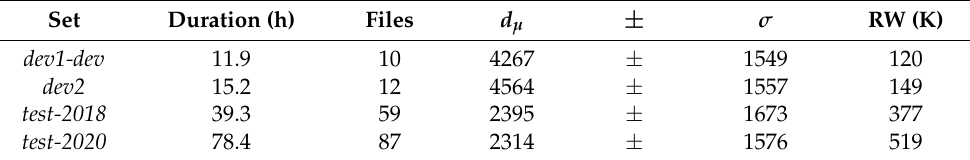
Table 3. Basic statistics of RTVE development and tests sets, including our internally split dev1-dev set: total duration (in hours), number of files, average duration of samples in seconds plus-minus standard deviation ( d µ ± σ ), and running words (RW) in thousands (K). Set